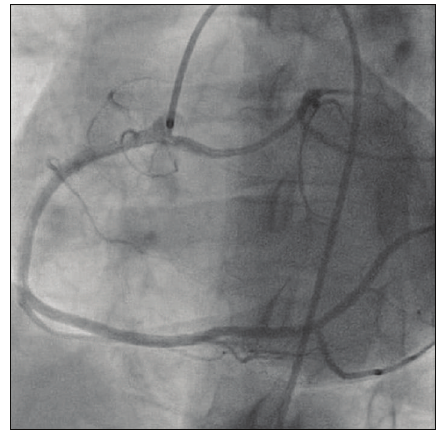
Figure 3: Right anterior oblique-cranial view of left main coronary artery with an anomalous origin off the right sinus of Valsalva with interarterial